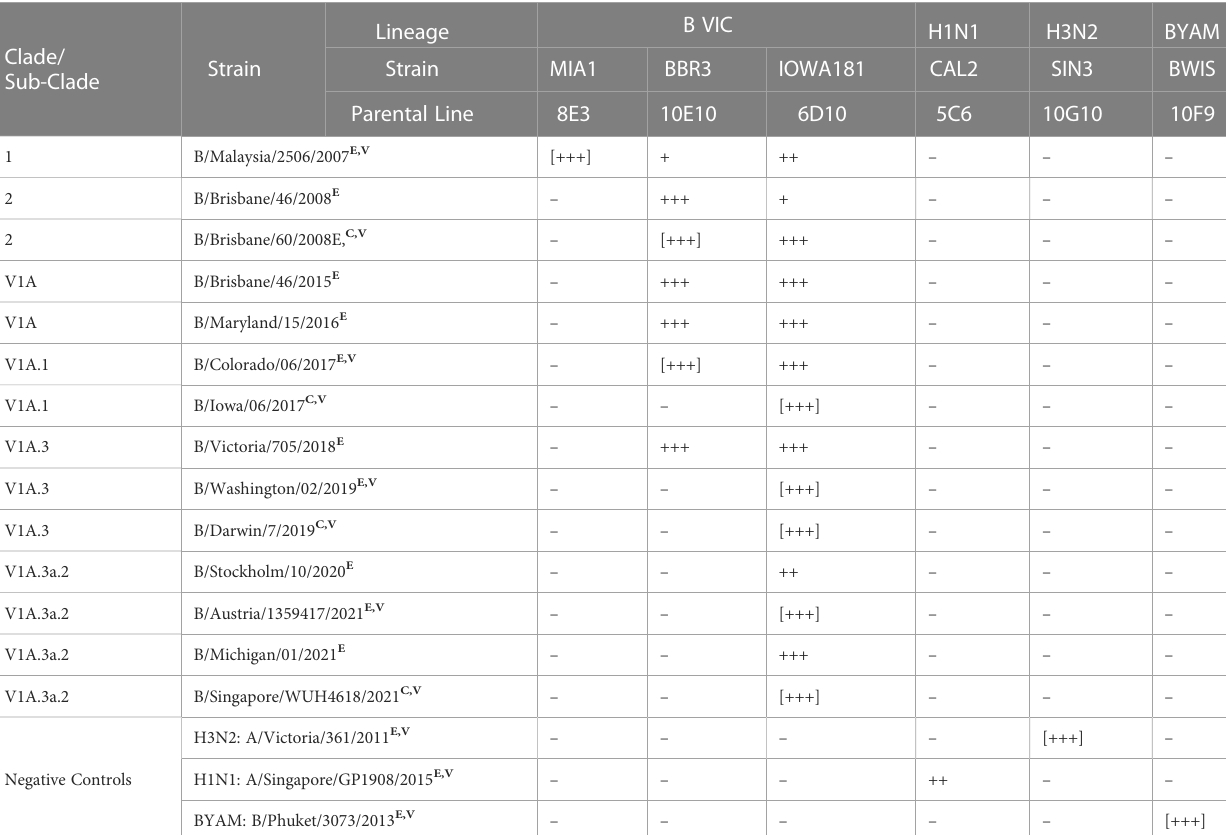
TABLE 3 Cross reactivity of monoclonal antibody (mAb) panel speci fi c to in fl uenza B Victoria lineage screened against egg derived (E) and cell derived (C) vaccine antigen.